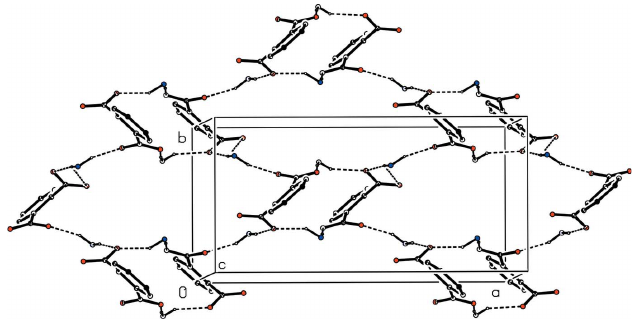
Figure 8 A schematic representation of part of the crystal structure of compound (II) showing the formation of a sheet of R 4 Hydrogen bonds are drawn as dashed lines and, for the sake of clarity, the H atoms of the anions have been omitted and only the NH 2 groups of the cations are shown.